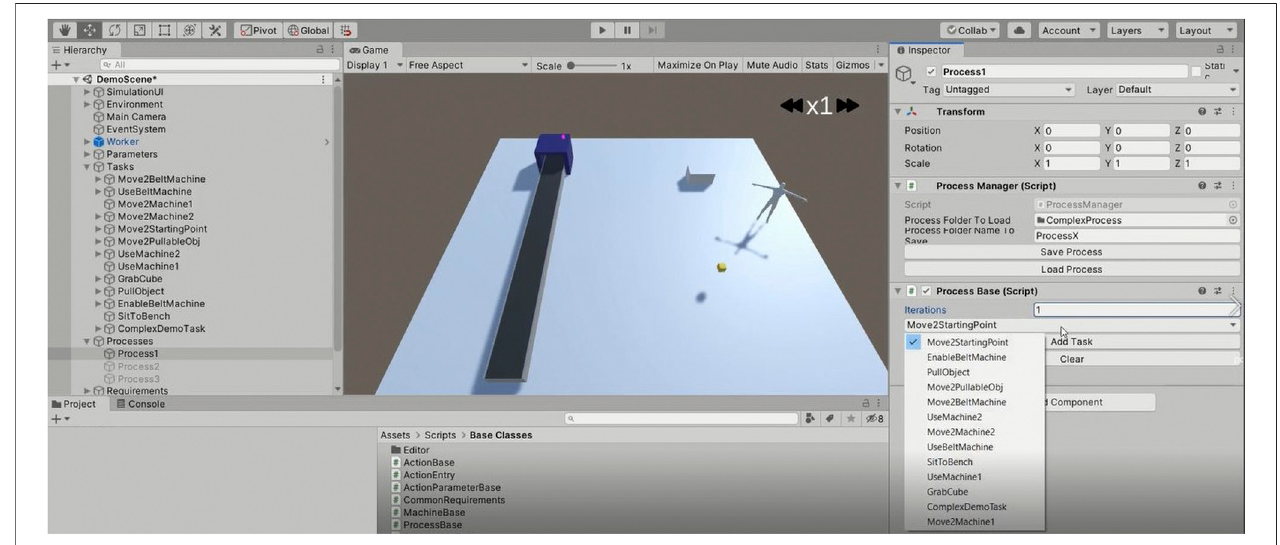
FIGURE 4 | Overall view of the DHM-based simulation module.